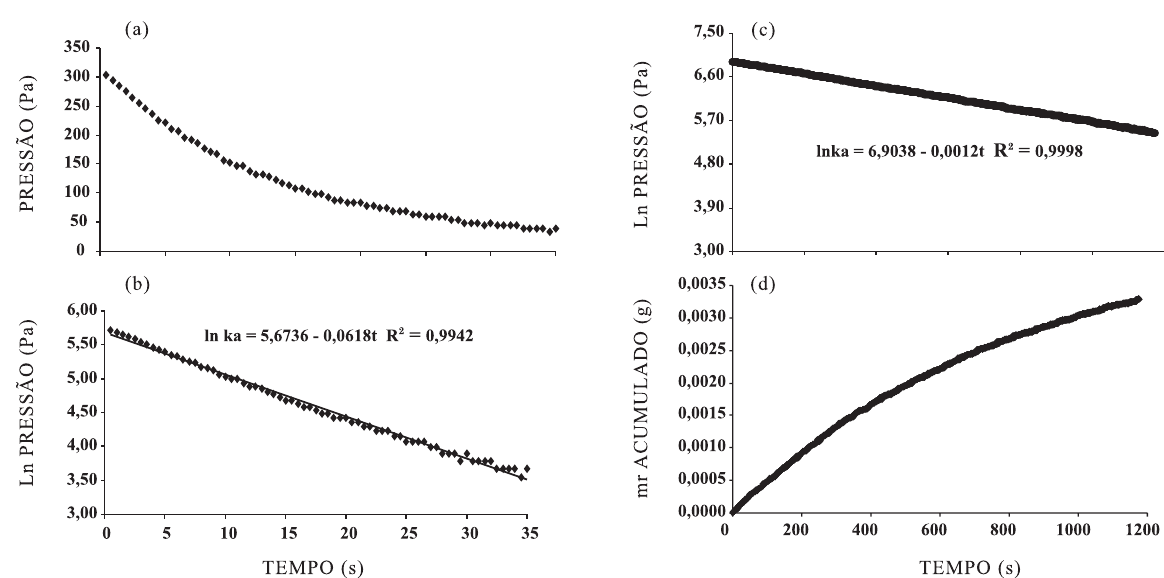
Figura 4. Os gráficos (a) e (b) correspondem à medida da pressão em função do tempo para os valores originais e transformados em logaritmo natural. Os gráficos (c) e (d) correspondem ao logaritmo natural da pressão e massa de água removida da amostra (Latossolo Vermelho) em função do tempo, respectivamente.